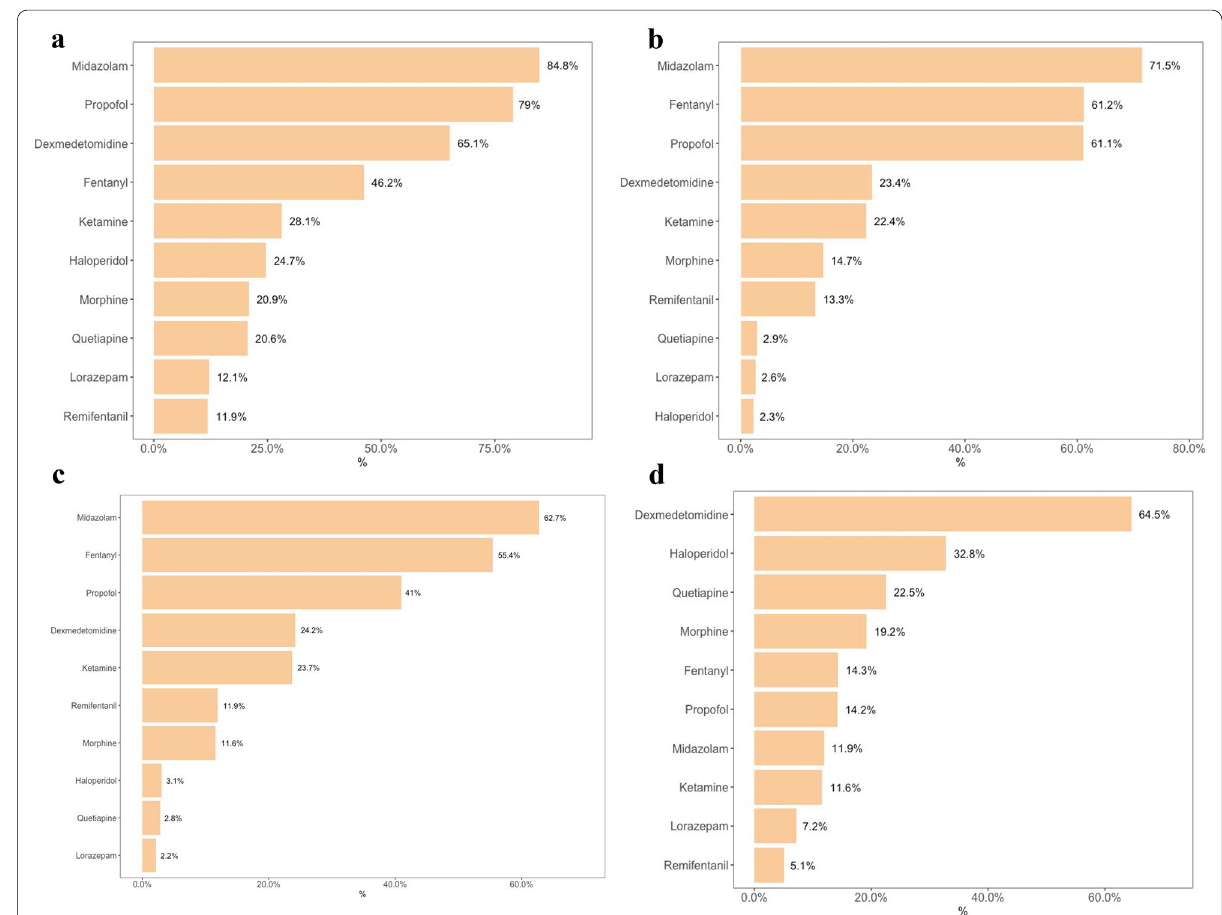
Fig. 2 Sedation practices in different clinical settings before the COVID‑19 pandemic. a Drugs usually used for sedation in patients under MV; b drugs used for sedation in patients with moderate‑to‑severe acute respiratory distress syndrome (ARDS) [25]; c drugs used for sedation in patients with septic shock; d drugs used for sedation in patients under noninvasive